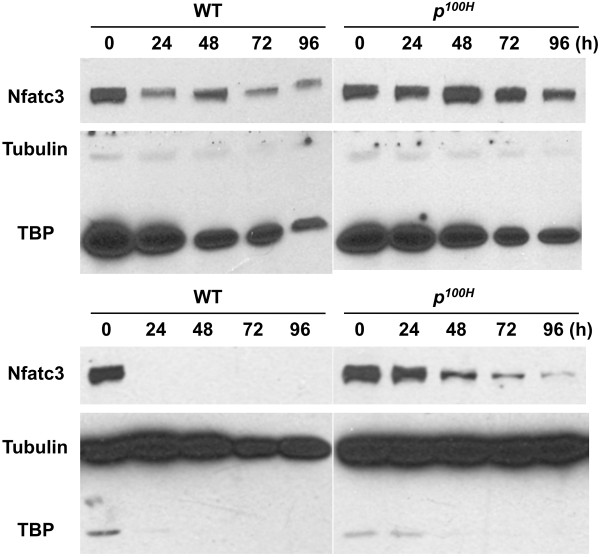
Nfatc3 protein levels are increased in both the nucleus and cytoplasm of Sox6-null myotubes. Wild type (WT) and Sox6-null (p100H) fetal primary myoblasts or myotubes were harvested at 0, 24, 48, 72, and 96 h after switching to DM, and nuclear and cytoplasmic protein was extracted for Nfatc3 Western blotting. TATA binding protein (TBP) and tubulin were used as loading controls for nuclear and cytoplasmic fractions, respectively. Upper panels: nuclear fractions. Lower panels: cytoplasmic fractions.